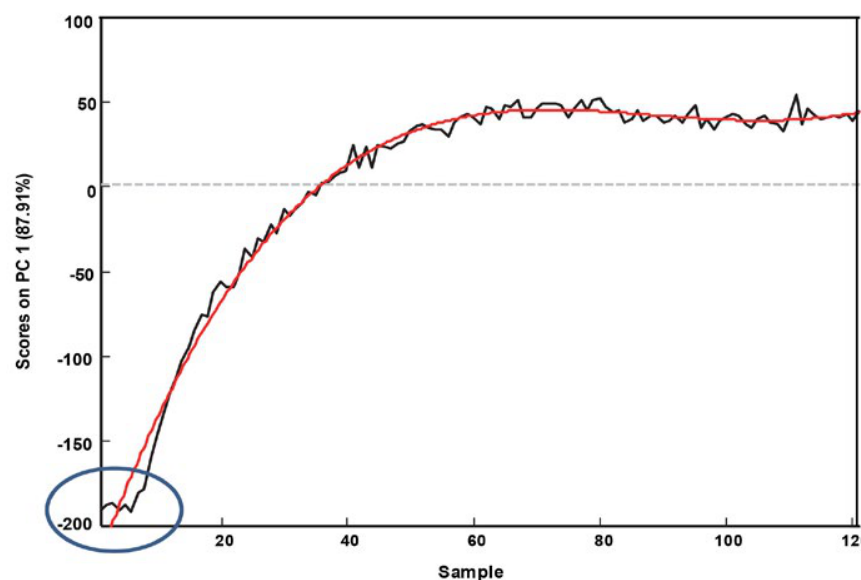
Figure 4 . Samples and scores plot of the data in 1200–1320 cm –1 region. The red line shows the 4 th degree polynomial fit.